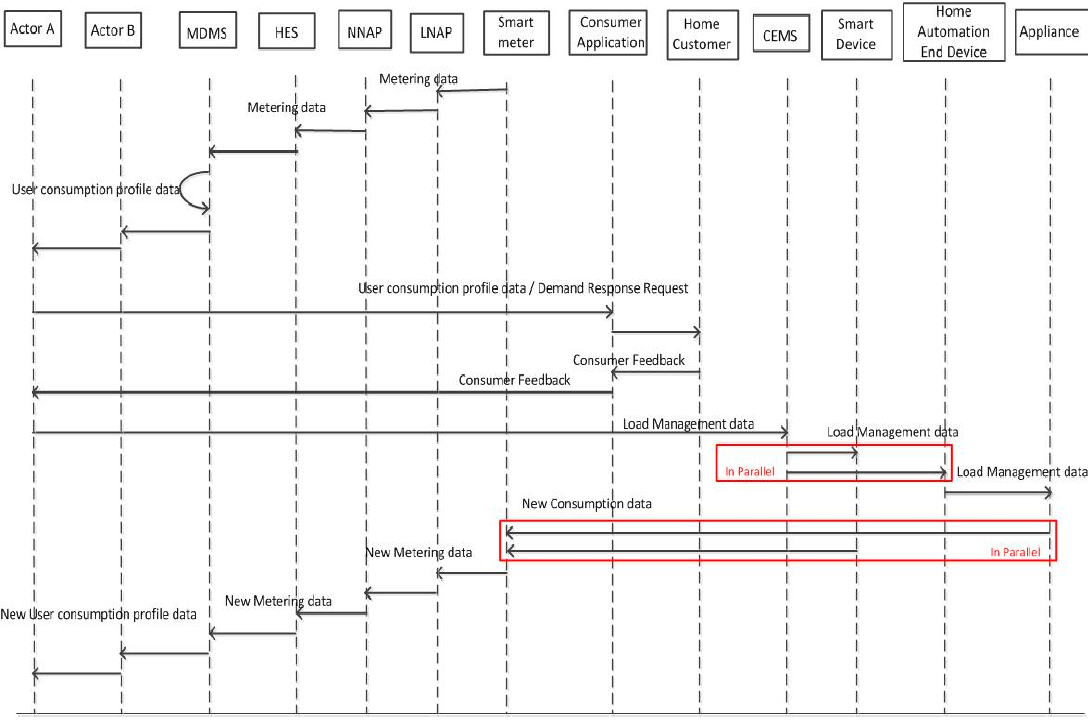
Figure 3. Message Sequence Chart. Table 2. Step by Step Analysis of Use Case.